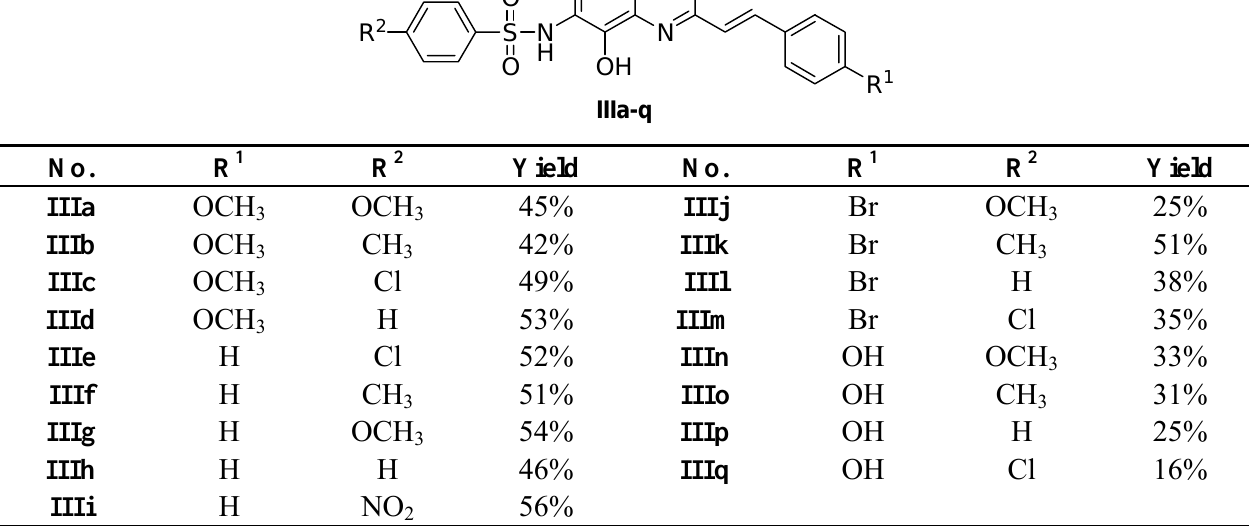
Table 1. The yields of styrylquinolin-7-yl-benzenesulfonamide derivatives III